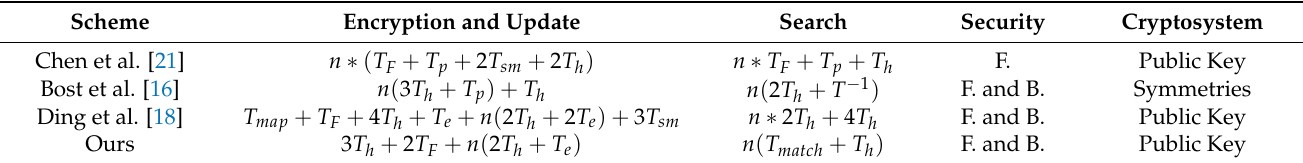
Table 3. Comparison of different DSE schemes.